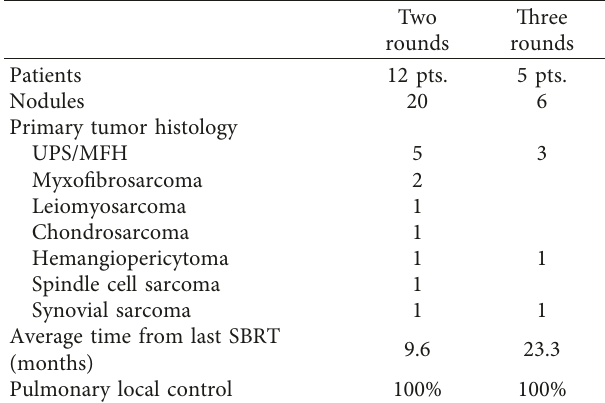
Table 3: Patients with